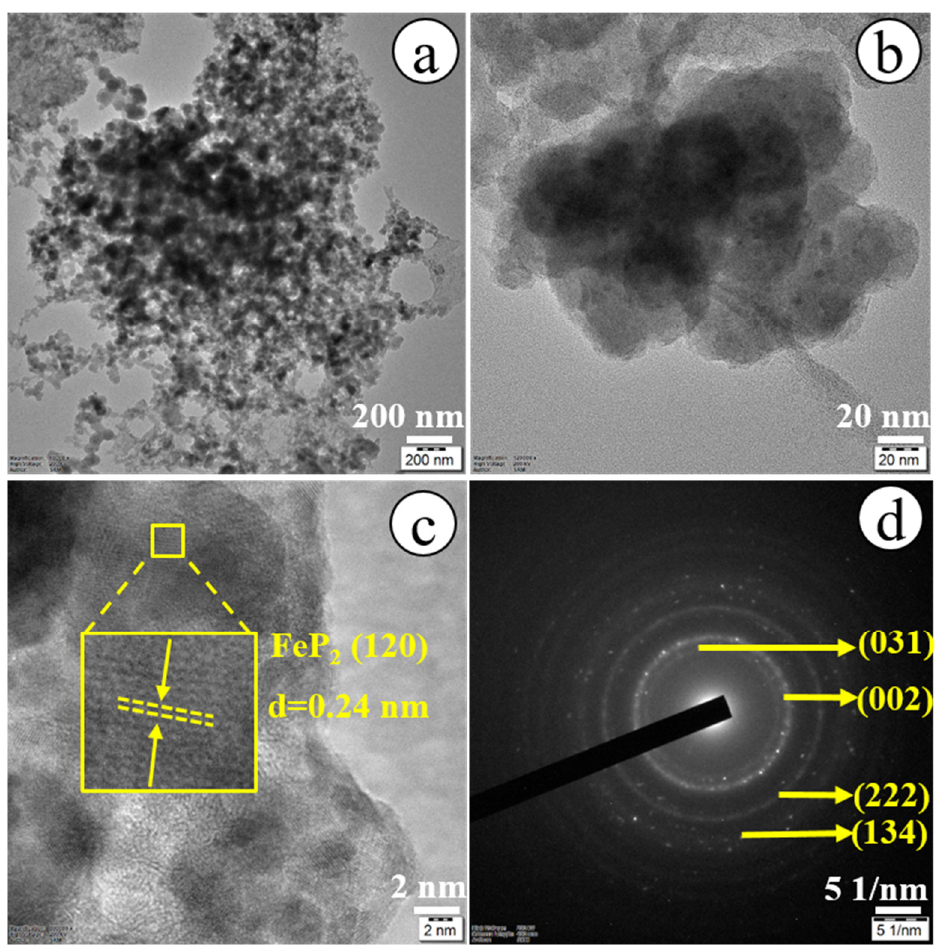
Figure 9. TEM images of the low magnification ( a ) and high magnification ( b ), HRTEM image ( c ), and SAED pattern ( d ) for the PS-3D-FeP@NiO|Ni electrode measured after a long-term stability test.